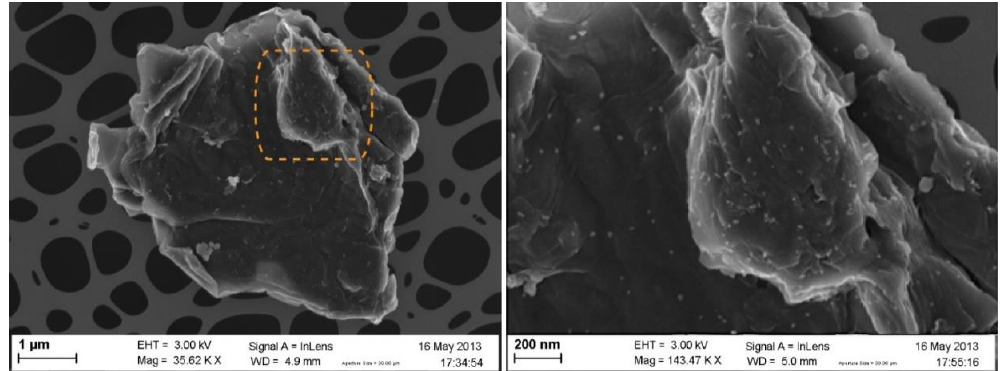
Figure 6. SEM images of the covalently-linked silica-coated Fe 3 O 4 magnetite nanocomposite. A magnification of the zone indicated by the dashed orange rectangle ( left image) was made to evidence the presence of a series of nanosized objects ( right image) considered to be the silica coated MNPs. However, much larger agglomerates, coexisting independently from the synthetized nanocomposites, were also found. In some cases, it seems that graphene sheets are wrapped around these agglomerates (Figure 7). These undesired objects are formed of magnetite @ silica core-shell nanoparticles.